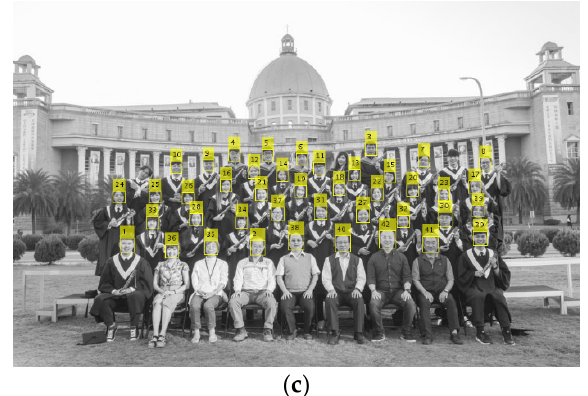
Figure 3. An example of face detection results using the VJ algorithm with different merging thresh- olds: ( a ) merging threshold = 1; ( b ) merging threshold = 2; ( c ) merging threshold = 3.